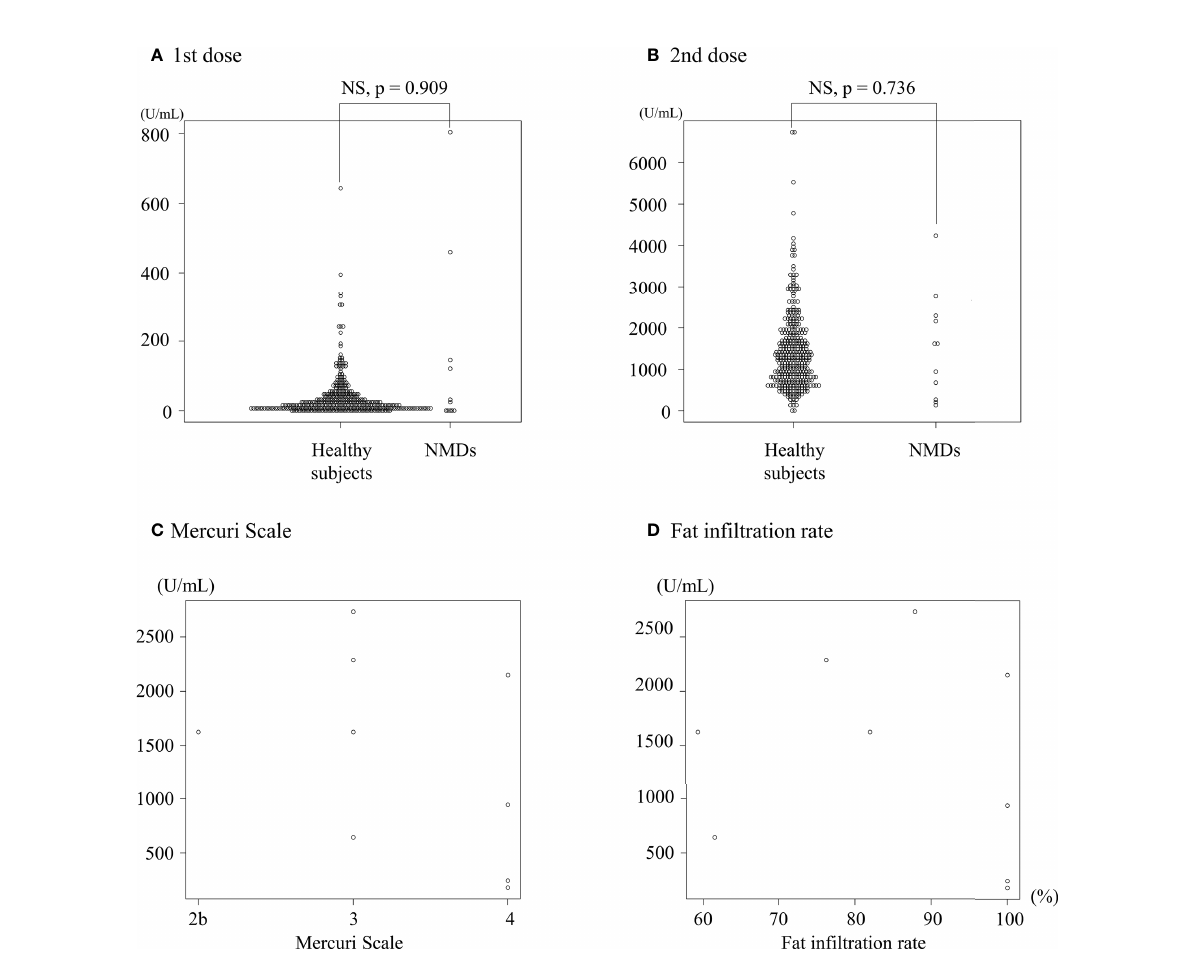
FIGURE 1 SARS-CoV-2 antibody titers after vaccination. SARS-CoV-2 antibody titers two weeks after the fi rst (A) and second (B) dose of vaccination in healthy controls (n = 346) and patients with neuromuscular disorders (NMDs) (n = 11). Fat in fi ltration in the deltoid muscle on the Mercuri Scale (C) and fat in fi ltration rate (D) , and SARS-CoV-2 antibody titers after the second dose of vaccination in patients with